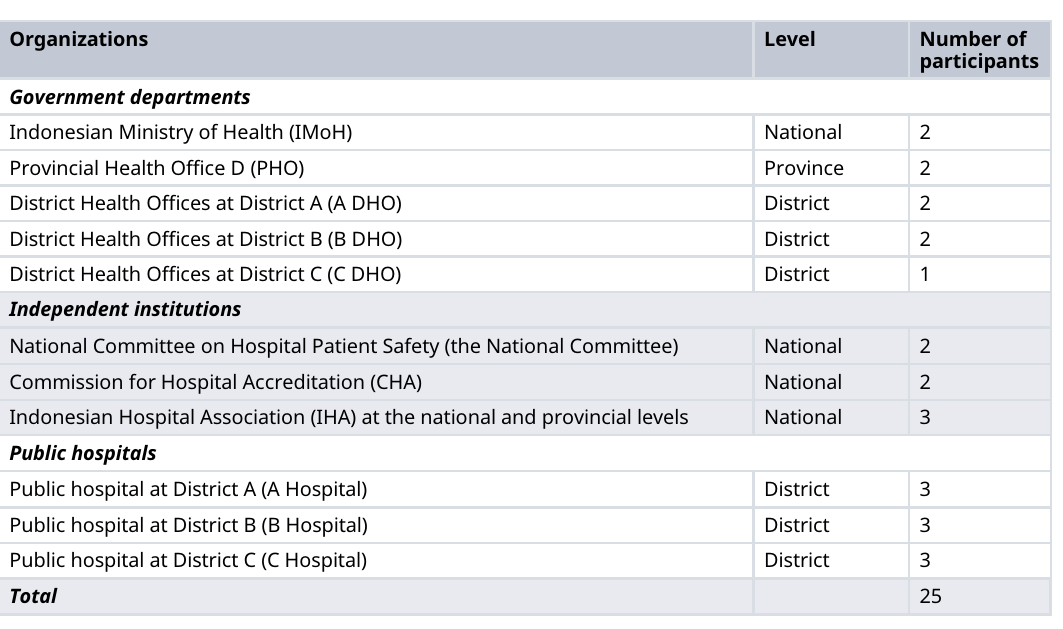
Table 1. Type of organizations and the number of